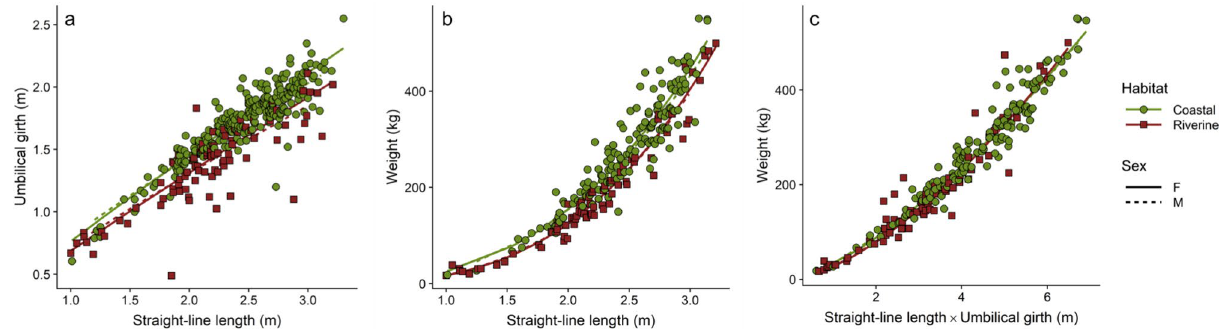
Figure 3. Relationships between: ( a ) Umbilical Girth (UG) and Straight-line length (SL) ( n = 353); ( b ) Weight (W) and Straight-line length (SL) ( n = 234); and ( c ) Weight (W) and Straight-line length (SL) X Umbilical girth (UG) ( n = 225), from two habitat types. Lines indicate fit from a nonlinear robust